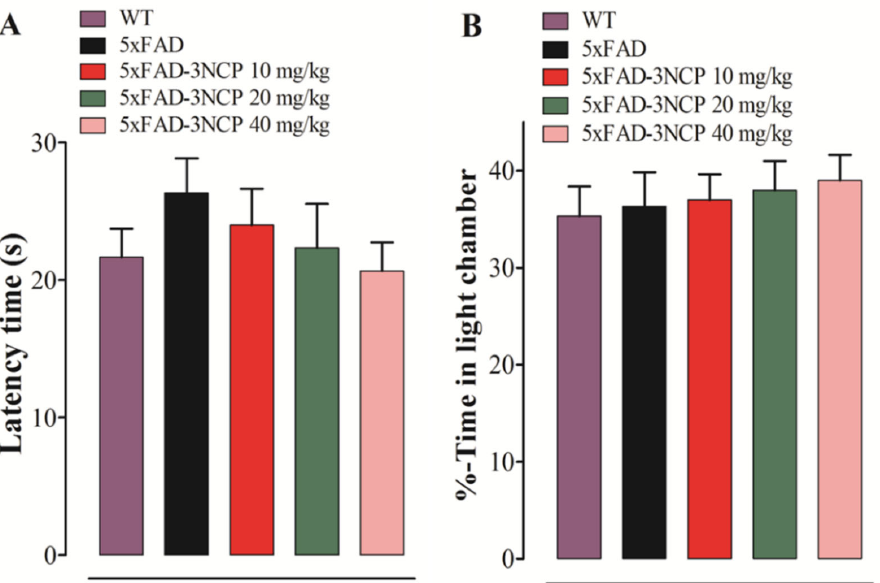
Figure 3. Effect of the 3NCP on time latency to enter the dark box from light box ( A ) and the percent time spent in the light chamber ( B ) in the light/dark box test.